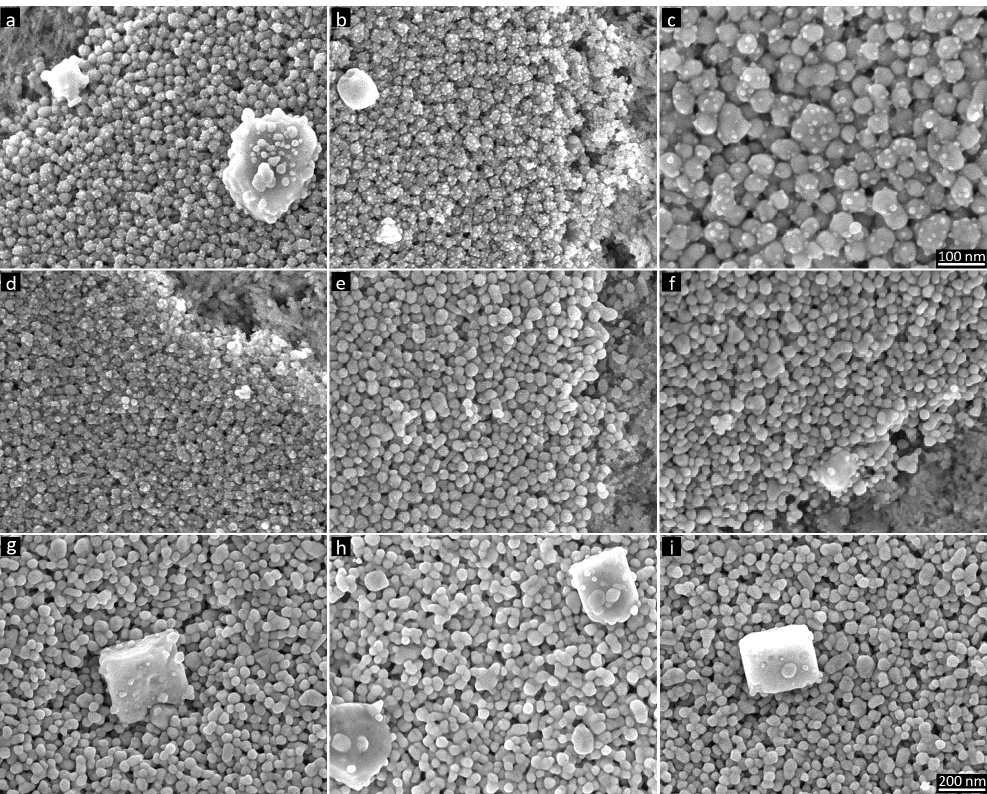
Figure 8. AgNP films on active papers and reference papers showing details of nanocrystal formation (SEM images). ( a ) HP10 active, ( b ) HP22 active, ( c ) HP22 active, ( d ) HP22 active (ethanol + EG), ( e ) HP22 reference, ( f ) HP22 reference (0.3 M KCl pretreatment), ( g ) HP22 reference (0.3 M KCl pretreatment), ( h ) HP22 reference (0.3 M KCl pretreatment + dipping), and ( i ) HP22 active (0.3 M KCl dipping) papers. All images are shown using the same scale, except for the top right image.